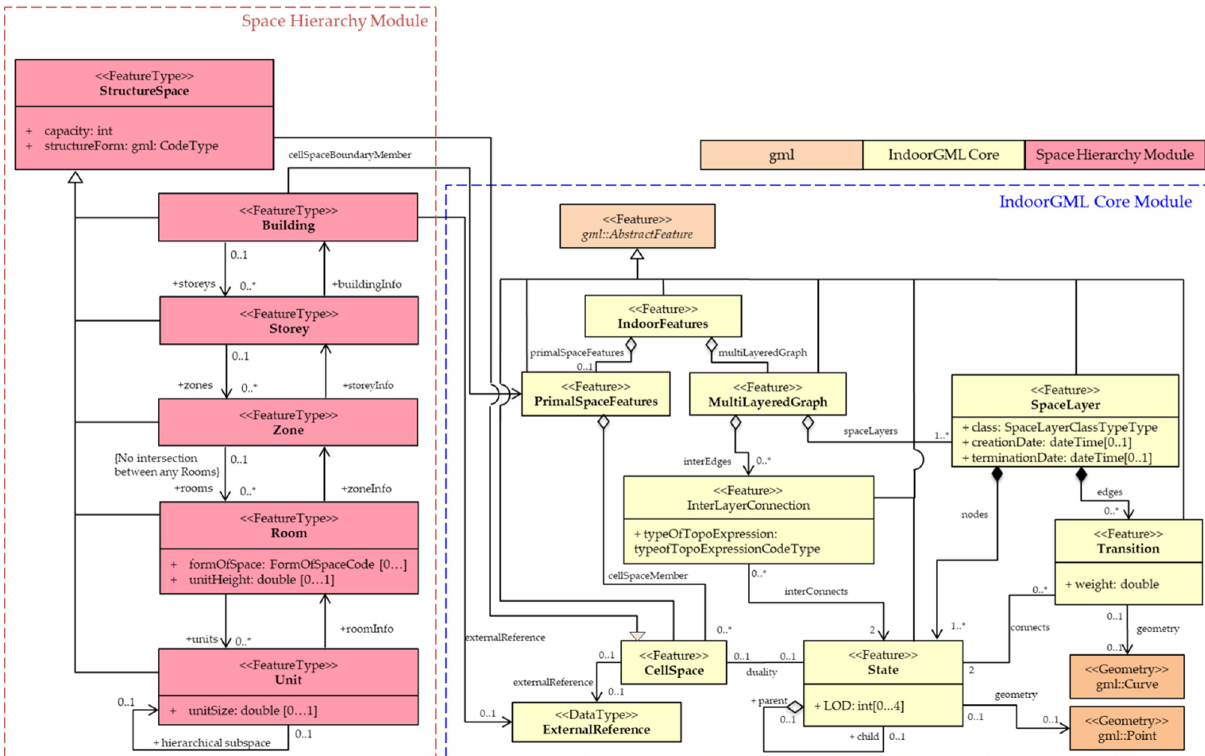
Figure 10. UML class diagram for IndoorGML extension module for representing hierarchical rela- tionships.